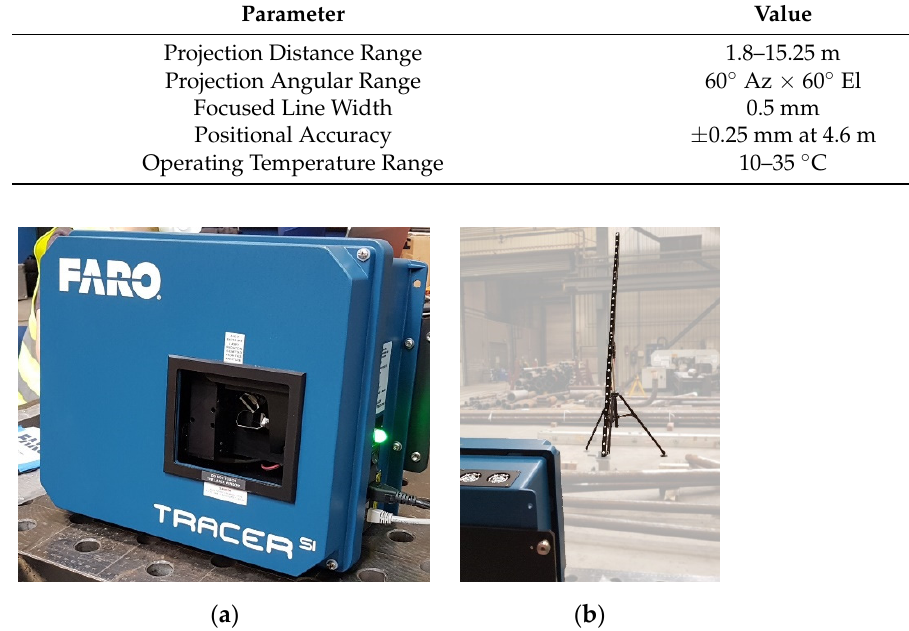
( b ) Figure 3. Compared standards: ( a ) calibration board and ( b ) ball-bar standard.